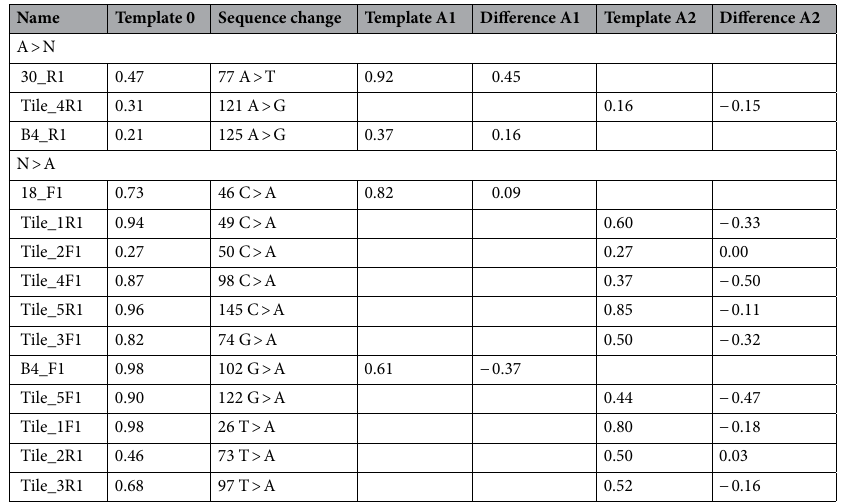
Table 3. Impact of preceding base. Fourteen blockers were tested on two templates, the original Template_0 and either Template_A1 or Template_A2. Both Template_A1 (Fig. S3) and Template_A2 (Fig. S4) have altered sequence adjacent to selected blocker binding sites. Below, the first three blockers involved a change from A to either T or G, while the last eleven blockers involved a change from C, G, or T to A. The initial blocking efficiency with Template_0 is shown in the second column and the second blocking efficiency is shown in the 4th or 6th column with all LNAs added at 1 µM.